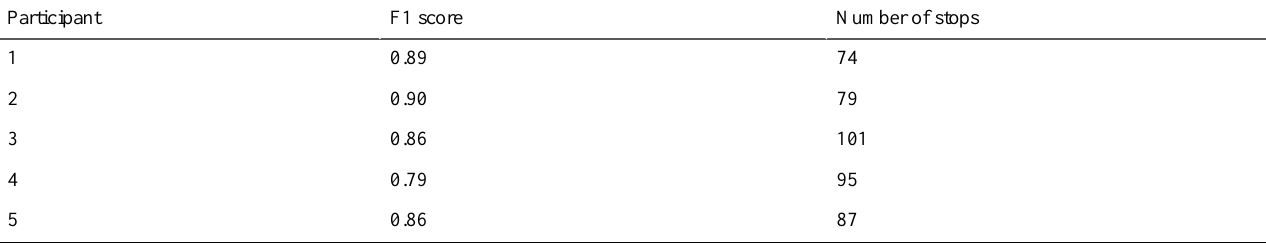
Table 6. Activity inference’s F1